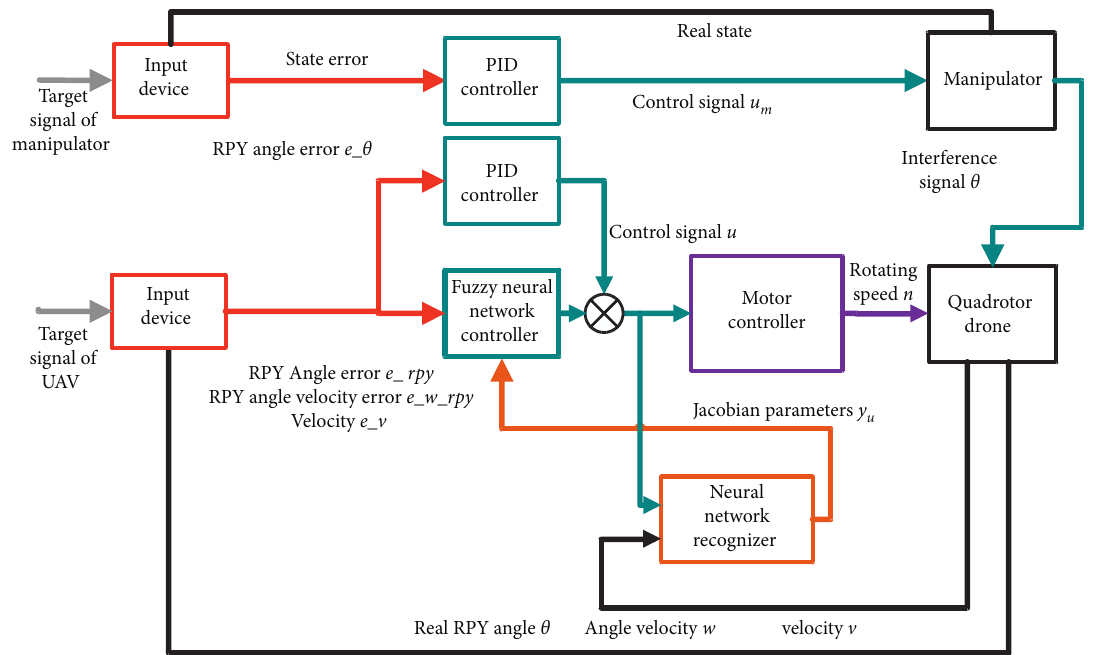
Figure 4: Aerial manipulator control